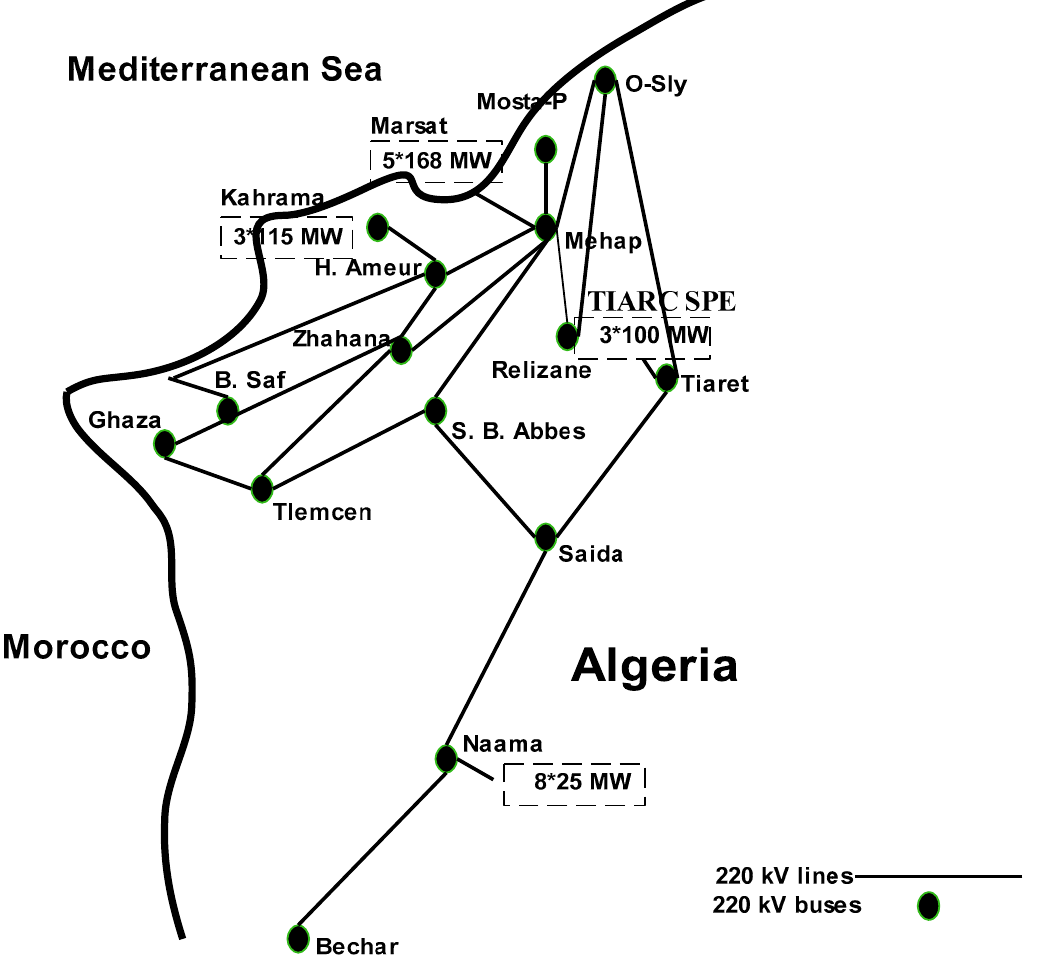
Figure 5. Map of the western Algerian electrical grid. Reproduced from reference [1].